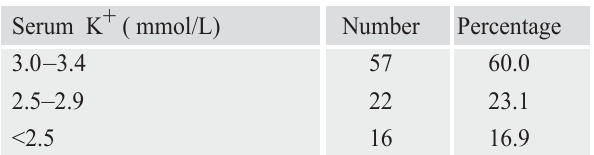
Table III: Serum potassium concentration of the study